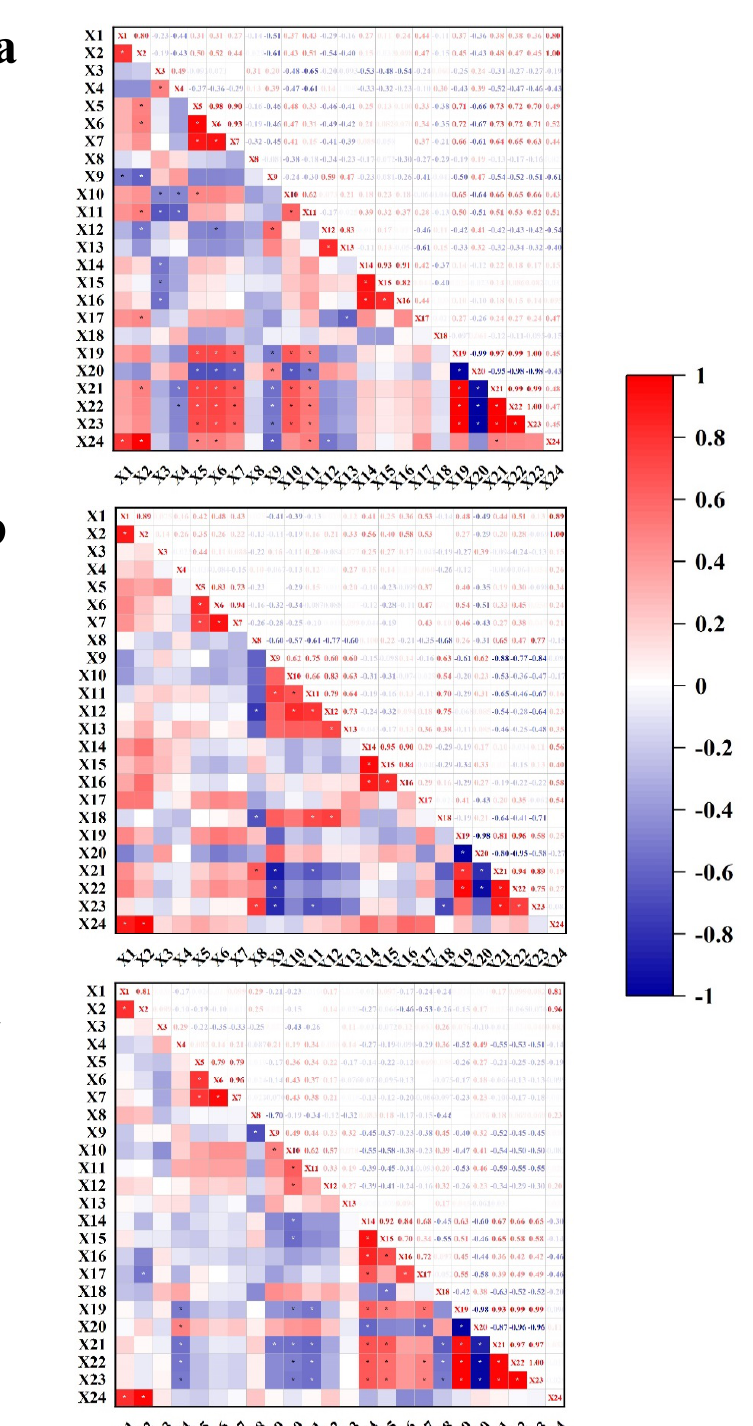
Figure 11. Correlation analysis of K fertilizers applied at different leaf ages during the panicle stage on yield and quality indexes. * p < 0.05. Note: X1: NO. of panicle per plant, X2: NO. of grains per panicle, X3: seed-setting rate, X4: 1000-grain weight, X5: brown rice rate, X6: milled rice rate, X7: head rice rate, X8: amylose contents, X9: protein contents, X10: albumin, X11: globulin, X12: prolamin, X13: glutelin, X14: peak viscosity, X15: hot paste viscosity, X16: cool paste viscosity, X17: breakdown viscosity, X18: setback viscosity, X19: appearance, X20: hardness, X21: viscosity, X22: balance degree, X23: taste value, X24: grain yield per